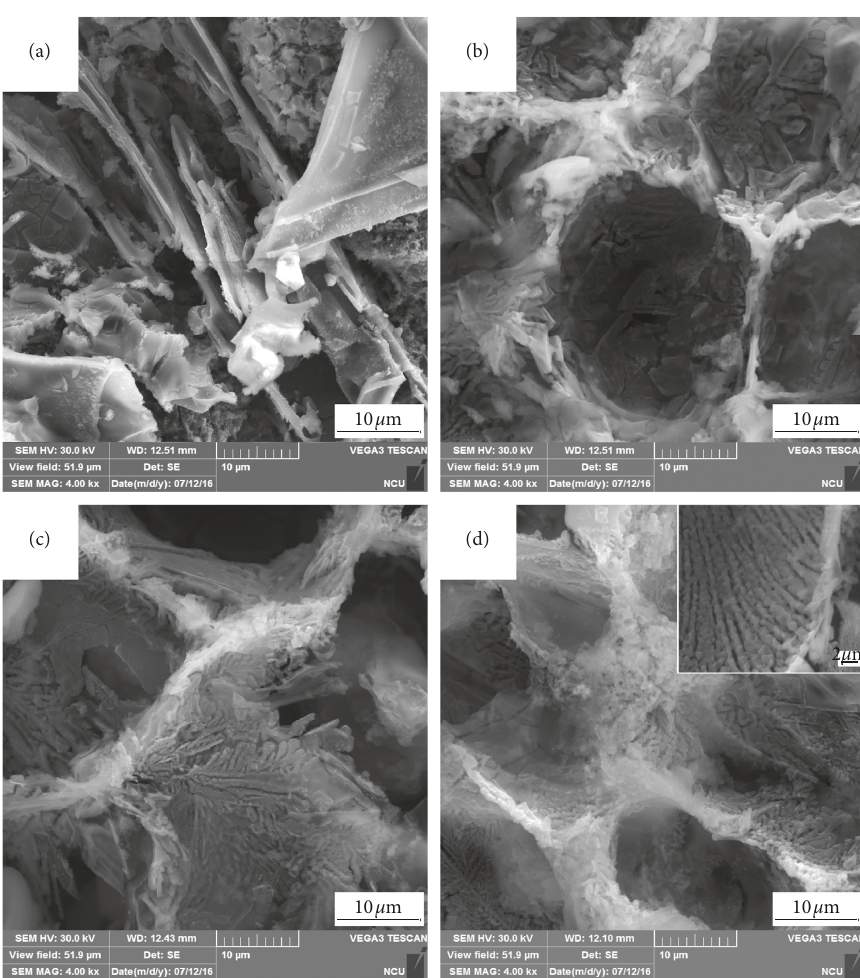
Figure 3: High magnification three-dimensional morphology of eutectic Si in Al-7 wt.%Si alloys: (a) unmodified, (b) Yb modified, (c) Sr modified, and (d) (Sr +Yb)